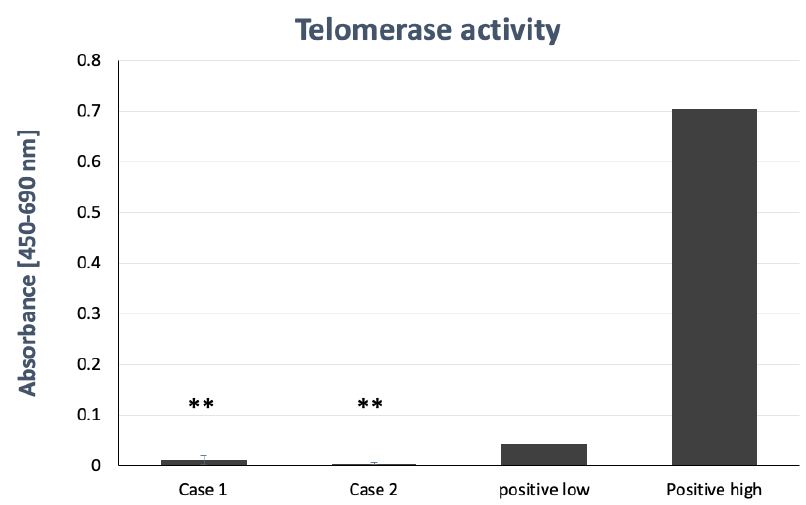
Figure 8. Telomerase activity assay of HBMSCs. The telomerase activity of HBMSCs were very low. A positive low pointed to the control group with low telomerase and positive high to the control group with high telomerase. (** p < 0.01 control compared with positive high).